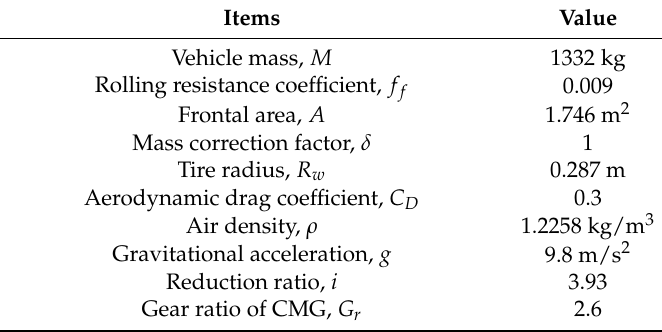
Table 2. Vehicle basic